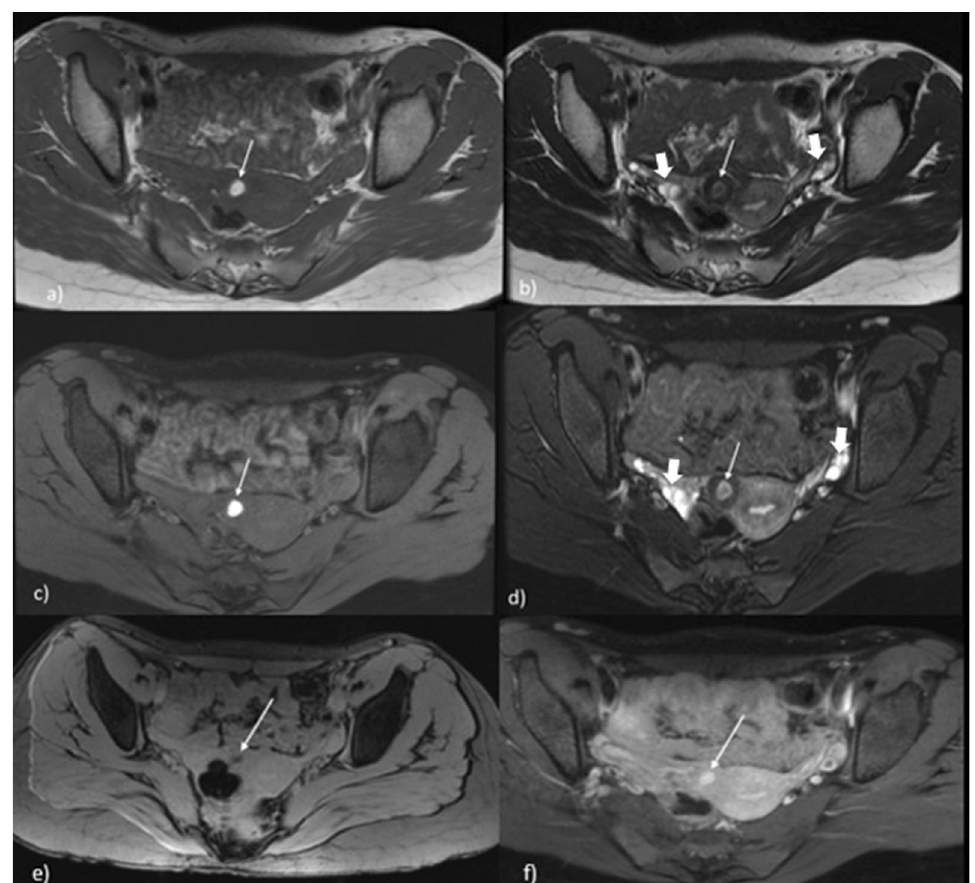
Fig. 2 MRI pelvis of a 17-year-old female with cyclic pelvic pain. Axial T1W SE image ( a ) shows a round hyperintense lesion (white arrow) in the right anterolateral myometrium, at the site of attachment of round ligament. Axial T2W SE image ( b ) reveals a thick-walled, round lesion with hypointense wall and shading of internal contents. Uterine endometrium is seen separately from the lesion. Both ovaries are normal (short white arrows). Corresponding axial T1W FS ( c ) and axial T2W FS ( d ) show no suppression of signal on fat saturated images, suggesting blood products. Axial T2* gradient-recalled echo (GRE) image ( e ) shows blooming of contents, confirming bleed. Axial T1W FS post-contrast image ( f )